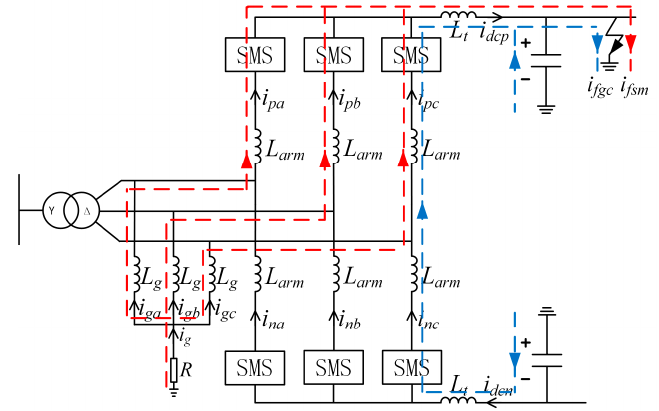
Figure 3. Fault current circuit in single-terminal MMC when positive pole-to-ground fault.